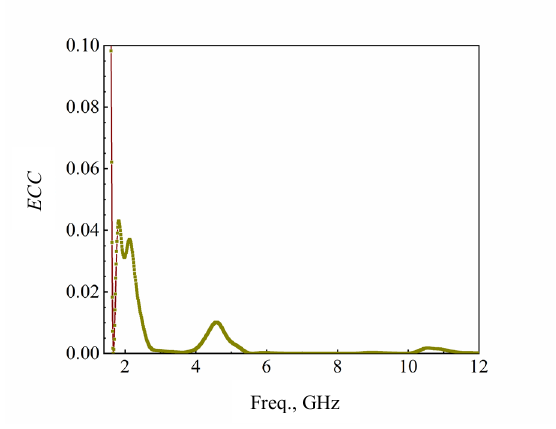
Fig. 12. ECC of UWB/MIMO antenna system.